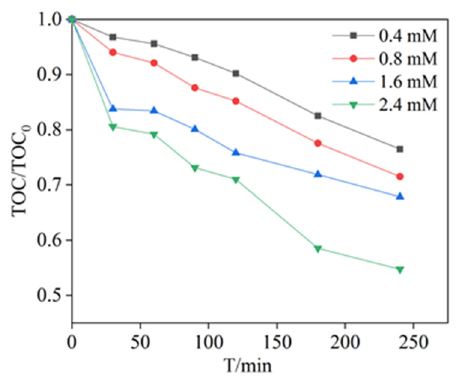
Figure 6. Effect of different PDS concentrations on the removal efficiencies of TOC by PDS catalyzed with MnFe 2 O 4 . Experimental conditions: [PCA] = 20 mg/L, [PDS] = 0.4–2.4 mM, [MnFe 2 O 4 ] = 1.3 g/L and T = 25 °C.